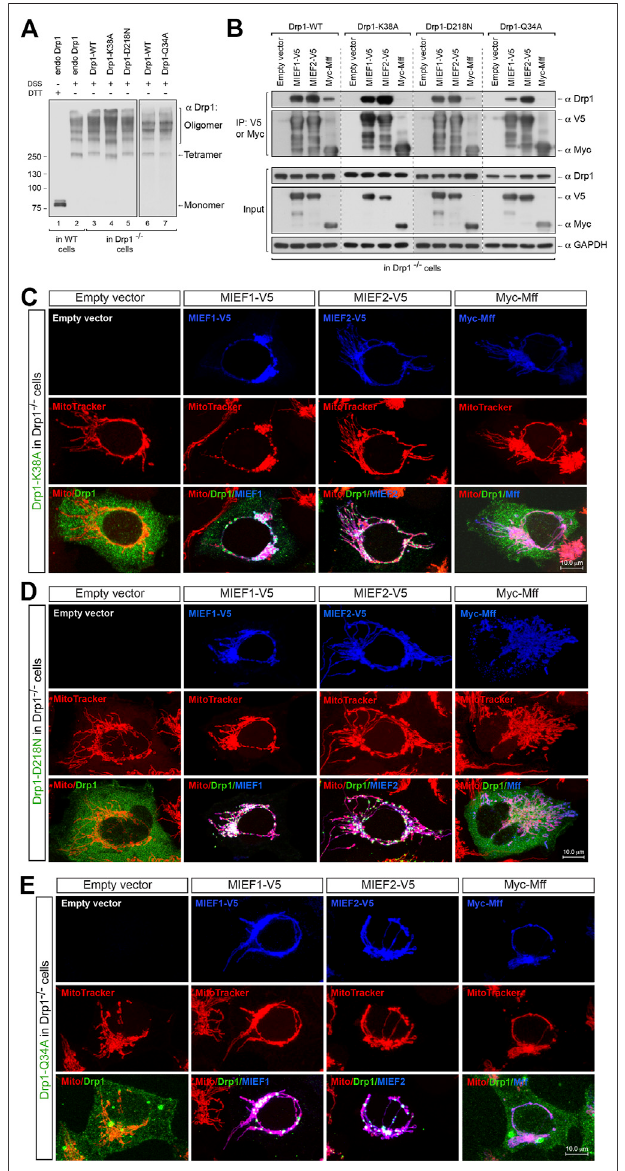
FIGURE 5 | MIEF1/2 but not Mff interact with and recruit the GTPase- defective mutants to the mitochondrial surface. (A) The oligomeric states of